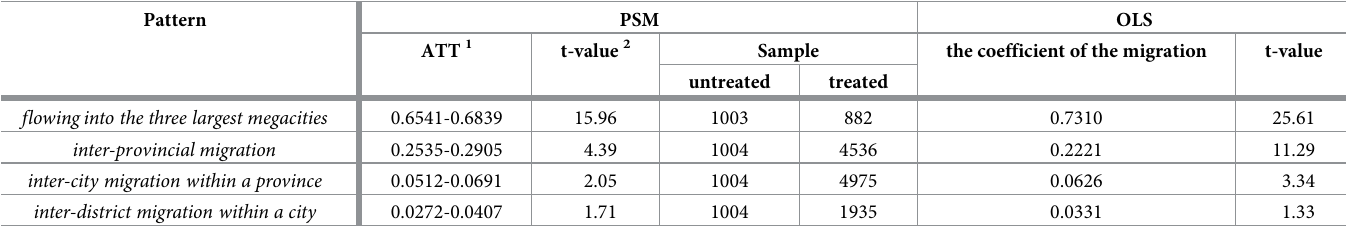
Table 9. The migration effect of the four patterns in the three northeastern provinces of China-OLS and PSM. Pattern PSM OLS t-value 2 Sample the coefficient of the migration t-value untreated treated flowing into the three largest megacities inter-provincial migration inter-district migration within a